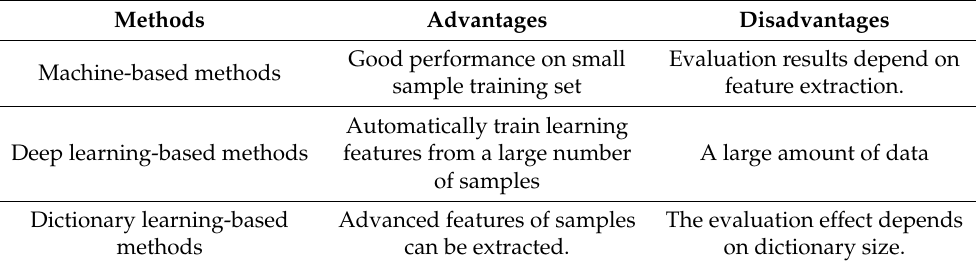
Table 2. Advantages and disadvantages of different learning-based